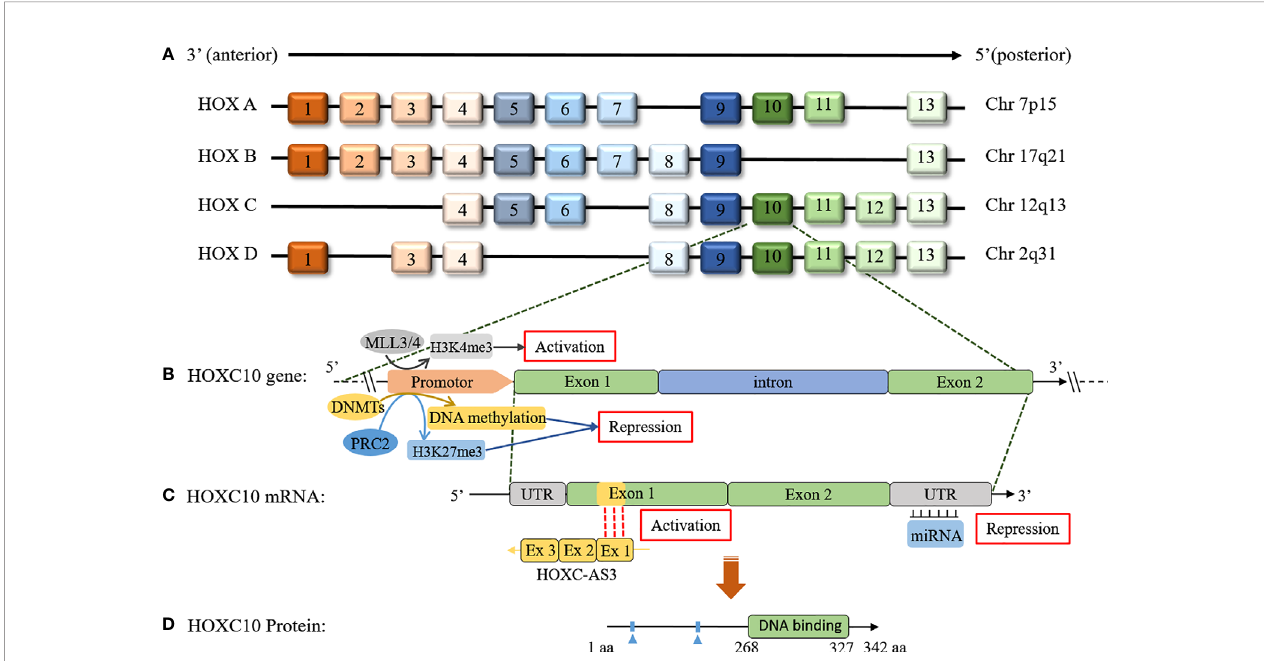
FIGURE 1 | Schematic of the HOX clusters and the HOXC10 gene, mRNA, and protein. (A) In mammals, 39 members exist in HOX genes and are distributed in four clusters. The HOX genes are distributed adjacent to each other in the clusters, and each cluster contains 9-11 members. (B) The HOXC10 gene consists of an intron and two exons. HOXC10 transcription is upregulated by MLL3/4 by histone methylation (H3K4me3) (5). HOXC10 transcription is downregulated by DNMTs via DNA methylation (6) or by polycomb-repressive complex 2 (PRC2) via histone methylation (H3K27me3) (7, 8). (C) lncRNA HOXC-AS3, a natural antisense transcript from the fi rst exon of the HOXC10 gene, can upregulate HOXC10 gene expression by interacting with exon 1 of HOXC10 (9). Additionally, miRNAs can post- transcriptionally suppress HOXC10 expression by base pairing with the 3 ’ -UTR of HOXC10 mRNA (10 – 12). (D) HOXC10 is a conserved of transcription factor that promotes target genes expression by interacting with target genes through the DNA binding domains